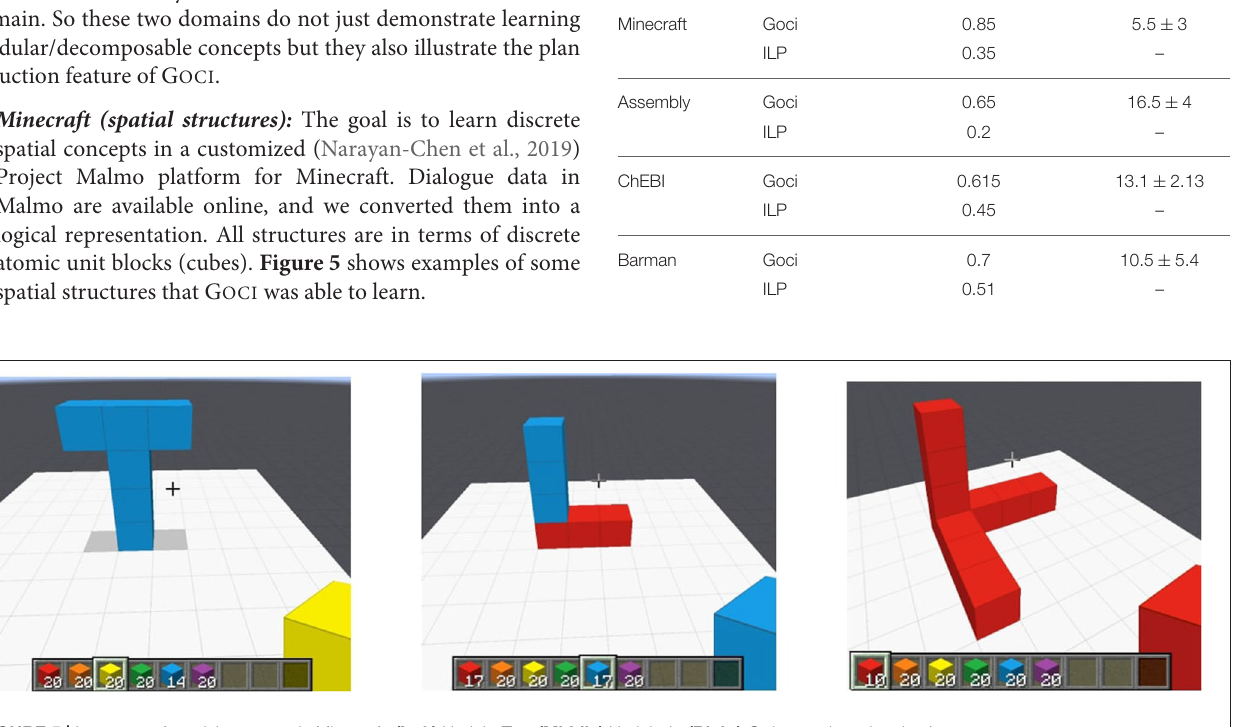
Frontiers in Robotics and AI |